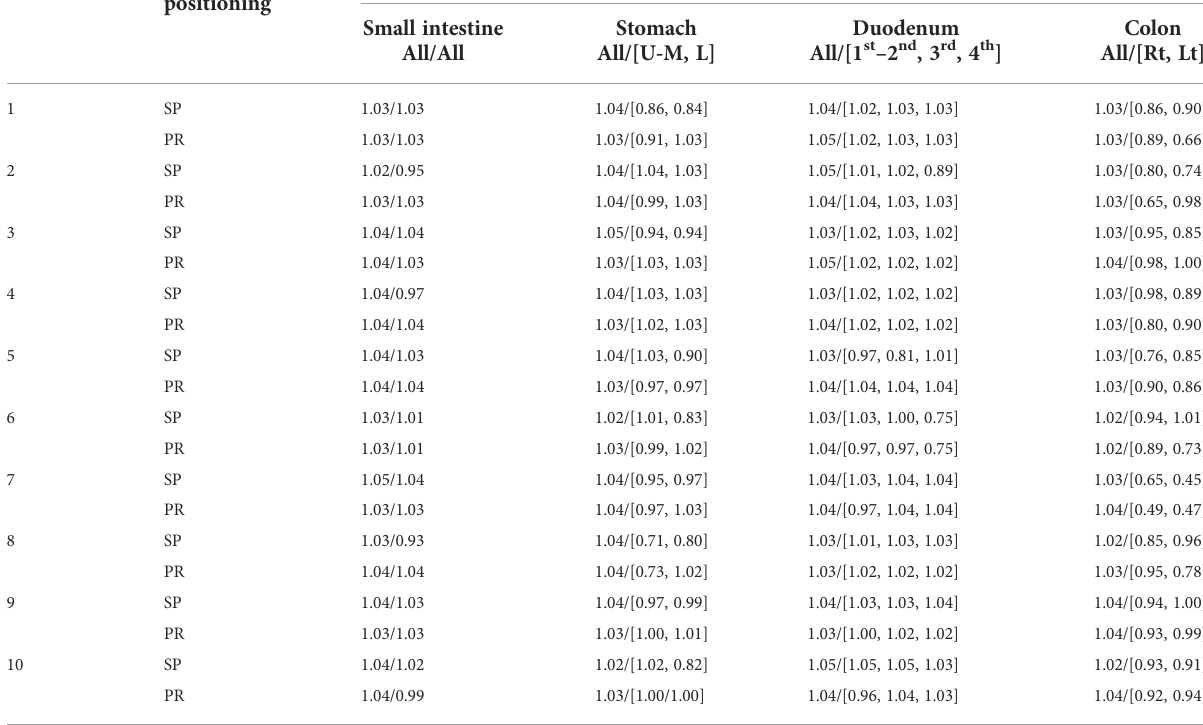
TABLE 2 Replacement values in the initial